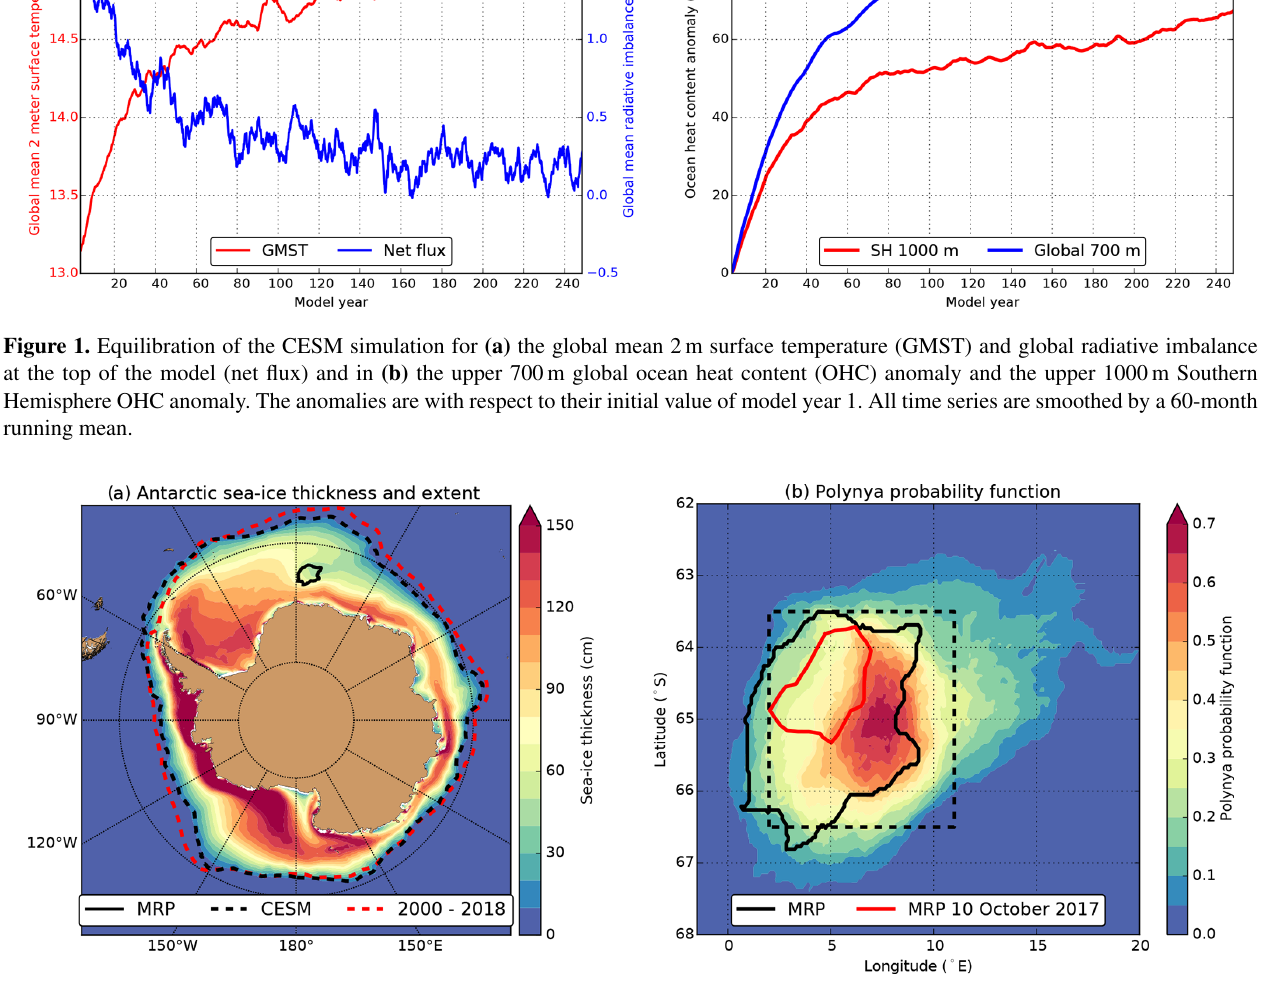
Figure 2. (a) Average sea-ice thickness (contours) for September over all the analysed years (model years 150–250) of the CESM out- put, including the time-mean September sea-ice extent (dashed black curve) and the time-mean (2000–2018) September sea-ice extent for the Scanning Multichannel Microwave Radiometer (SMMR) and Special Sensor Microwave Imager (SSM/I). The September model year 181 MRP is shown by the black contour in panels (a) and (b) . (b) Polynya probability function (explained in Sect. 2) based on all the polynya years. The dashed outlined region (66.5–63.5 ◦ S, 2–11 ◦ E) is defined as the polynya region. The observed 2017 MRP is indicated by the red contour in panel (b)